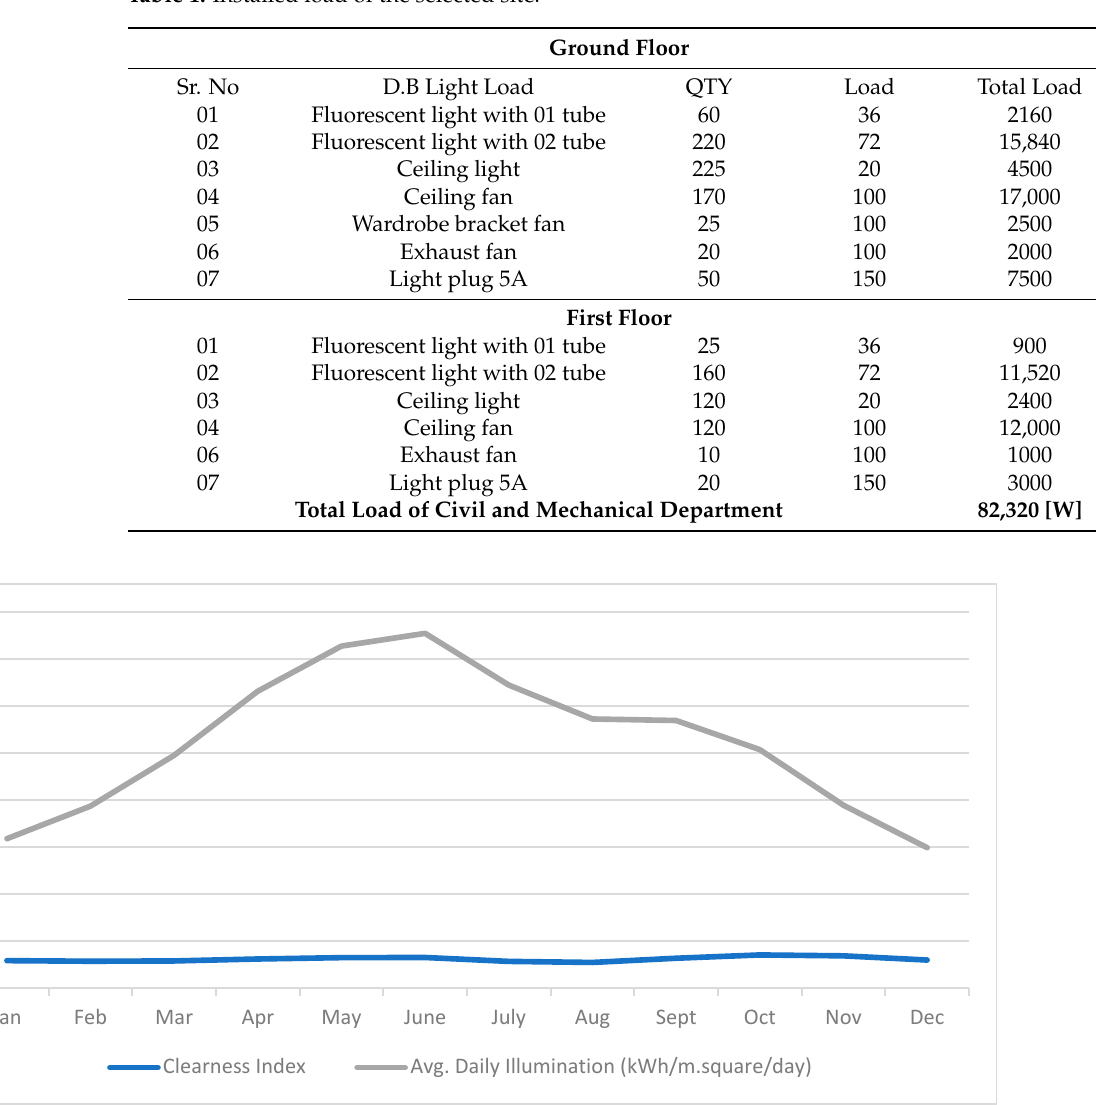
Table 1. Installed load of the selected site.